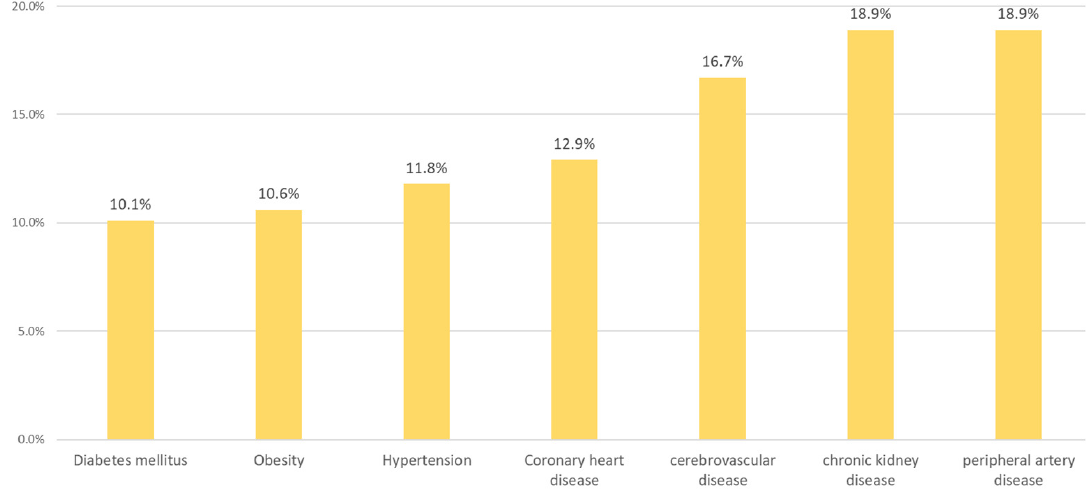
Figure 2. Comorbidities considered most frequent by the physicians.